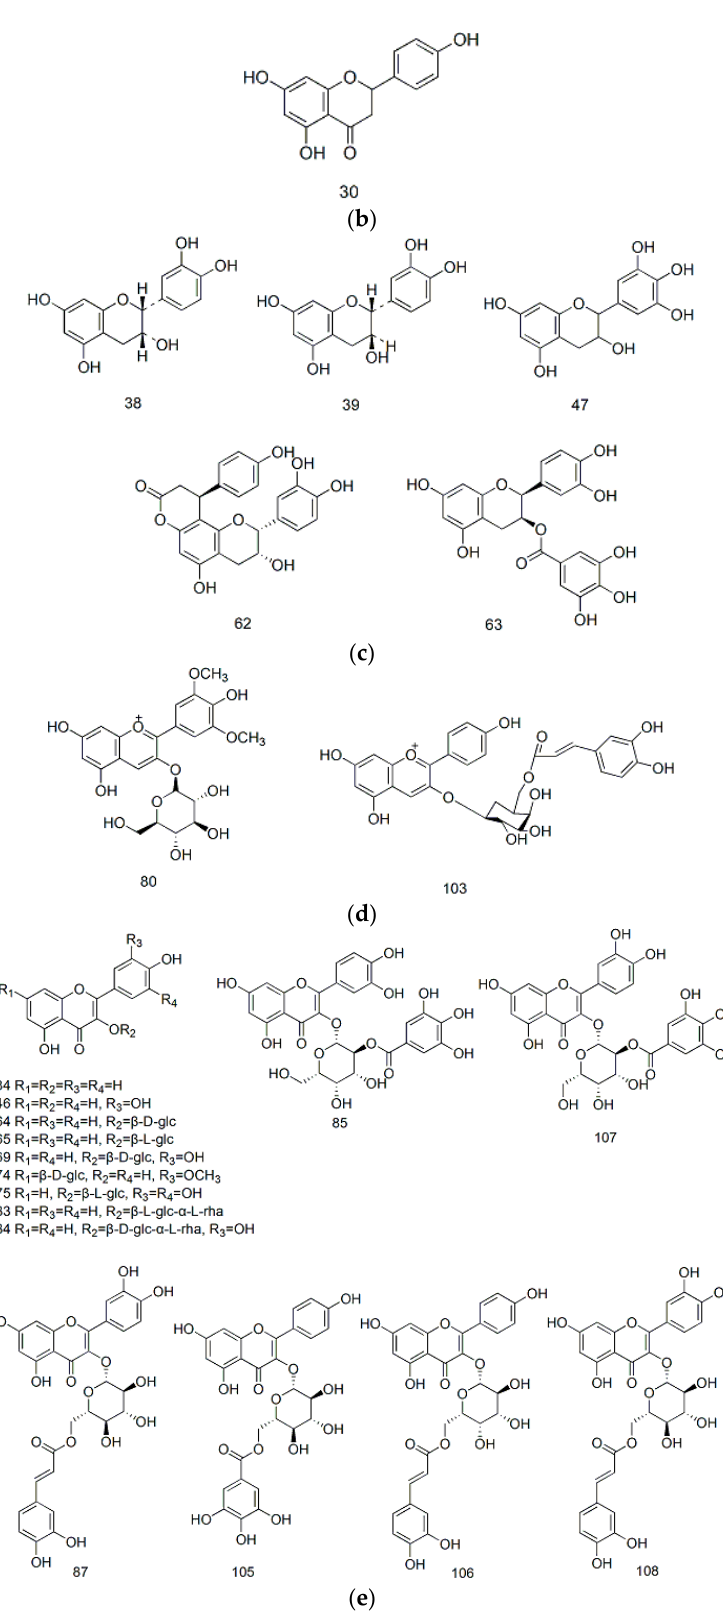
Figure 2. Structure of flavones ( a ); flavanones ( b ); flavan-3-ols ( c ); anthocyanidins ( d ); and flavonols ( e ).